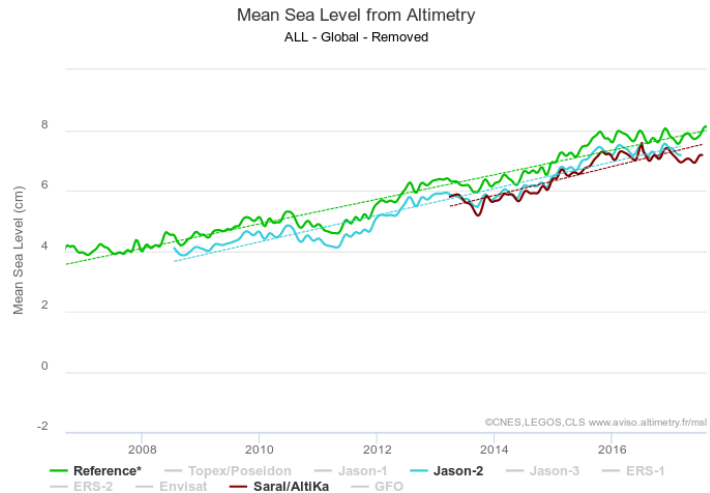
Figure 12. SARAL/AltiKa’s Global Mean Sea Level (red) compared to Jason-2 (blue) and the reference one